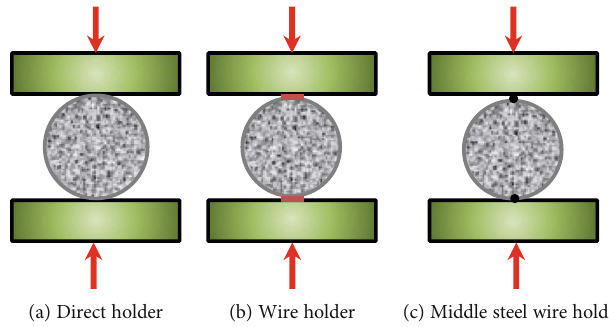
Figure 1: Diagram of loading mode for diametral splitting.